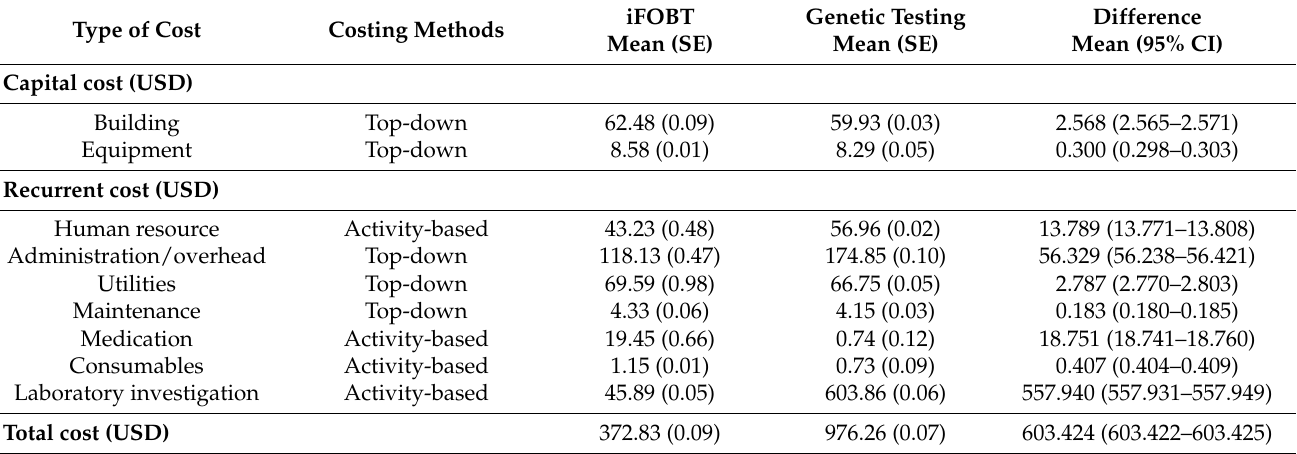
Table 2. Cost analysis of the iFOBT and CRC genetic testing